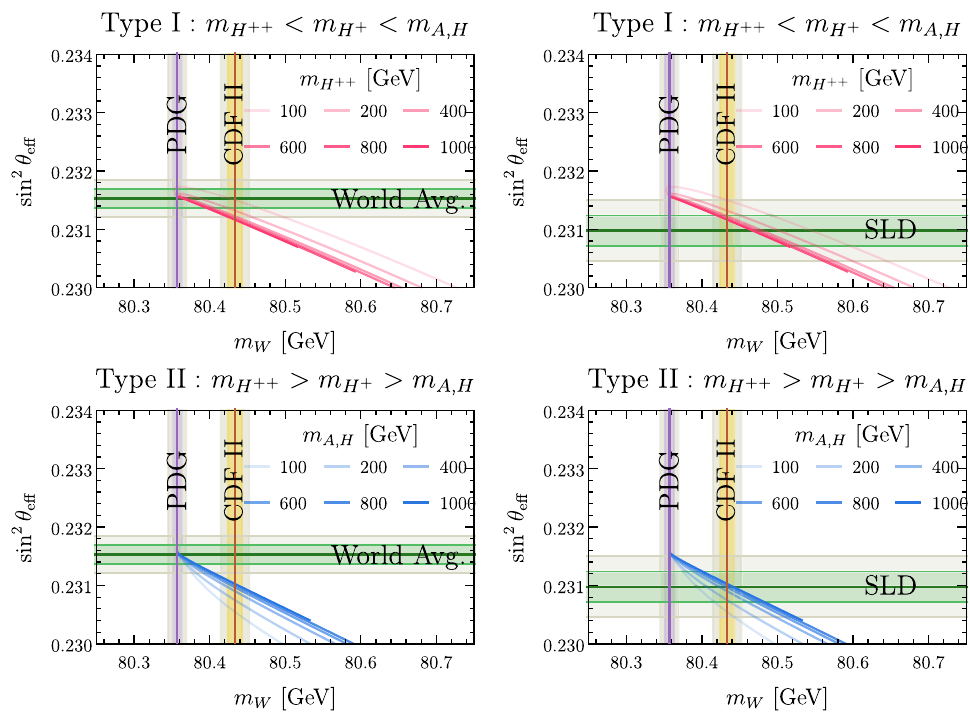
W boson mass and the yellow/gray band shows 1 σ /2 σ range. The dark purple line represent the PDG value for the W boson mass with the pur- ple/gray band showing the 1 σ /2 σ range. The dark green line in the left (right) column represent the world averaged value 0 . 23153 ± 0 . 00016 [2,95] (SLD measured value 0 . 23098 ± 0 . 00026 [95]) of sin 2 θ eff with the green/gray band shows 1 σ /2 σ